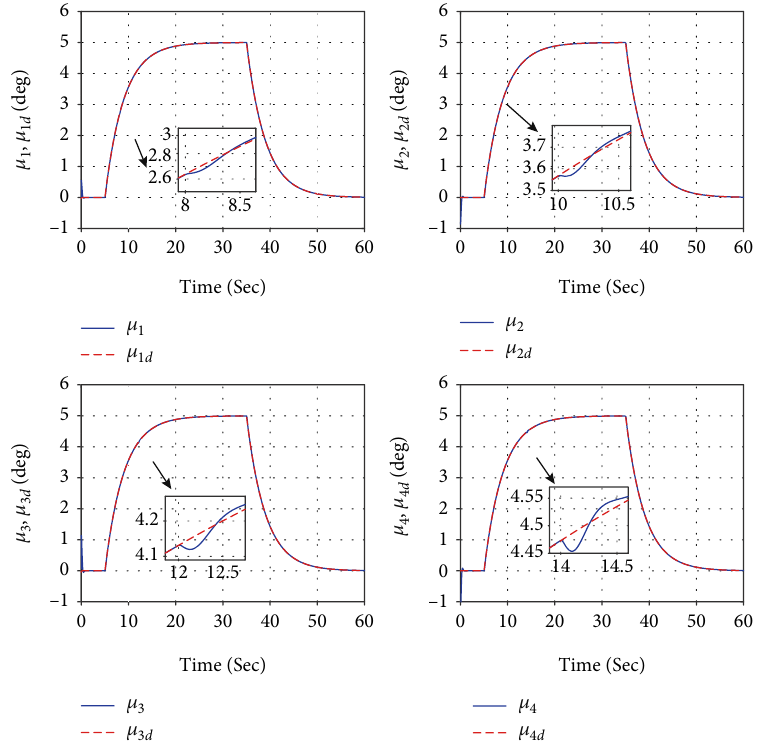
Figure 4: Bank angles μ